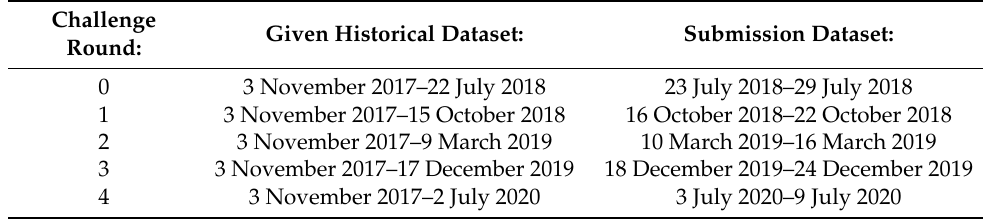
Table 4. Historical and submission sets for each